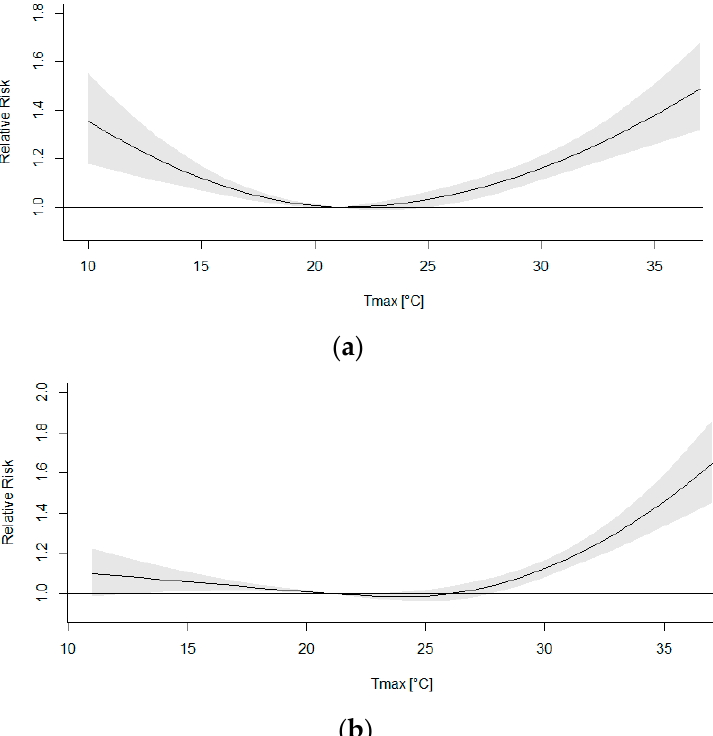
Figure 13. Relation between daily maximum temperature and relative mortality risk (cardiovascular diseases) in warm months (June–September) for towns with populations of 10–25 thousand in Wielkopolska: ( a ) 1989–1998; ( b ) 2001–2016.